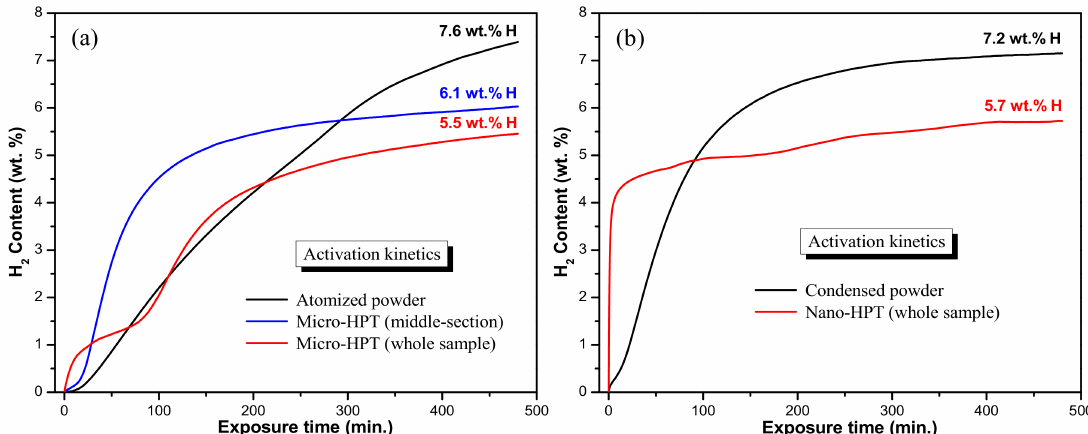
Figure 8. First hydrogenation profiles obtained by dynamic hydrogen absorption of the as-prepared samples at 400 ◦ C for 8 h under a hydrogen pressure of 3.5 MPa: ( a ) atomized powder and its 2 turns micro-HPT product; ( b ) condensed powder and its 2 turns nano-HPT